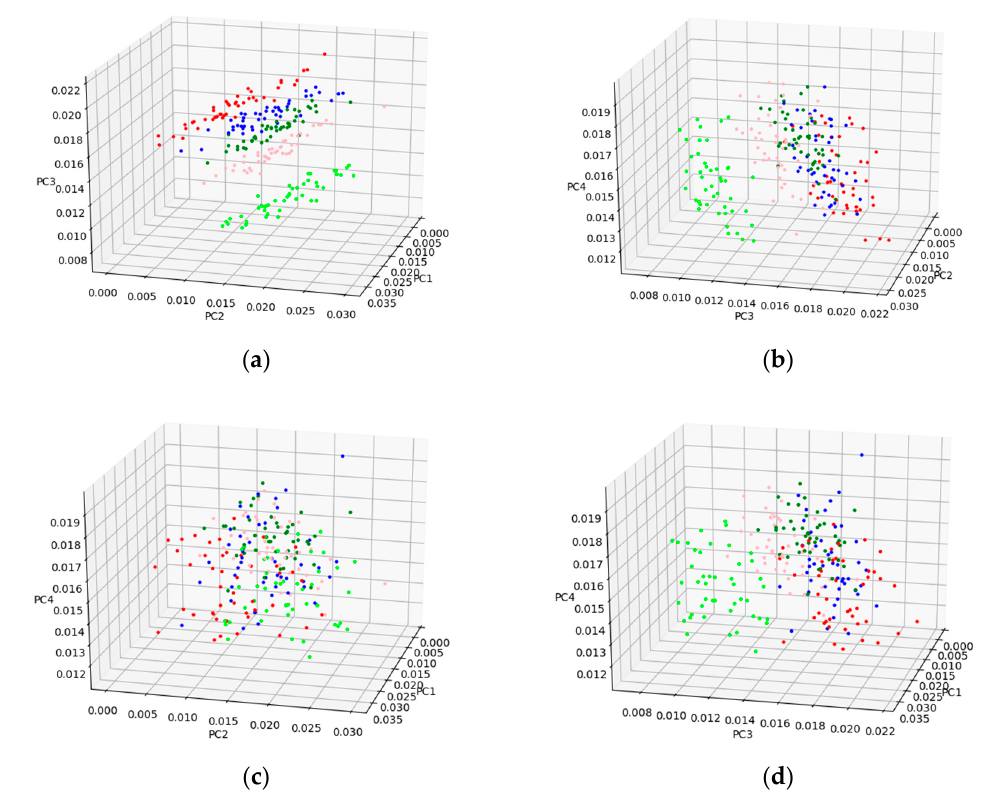
Figure 8. Clustering effect with three PCs (lime green, light pink, green, blue, and red represent 0, 10, 20, 50, and 100 ppb, respectively). ( a ) PC1, PC2, and PC3; ( b ) PC2, PC3, and PC4; ( c ) PC1, PC2, and PC4; and ( d ) PC1, PC3, and PC4.